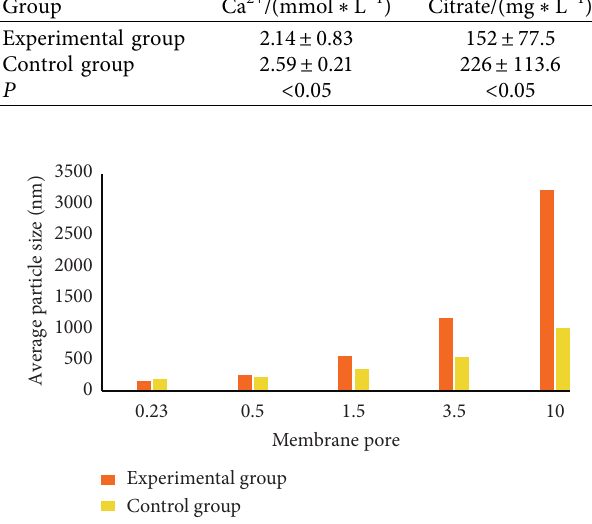
Figure 1: Mean particle size changes in urine nanocrystals filtered by organic membranes with different pore